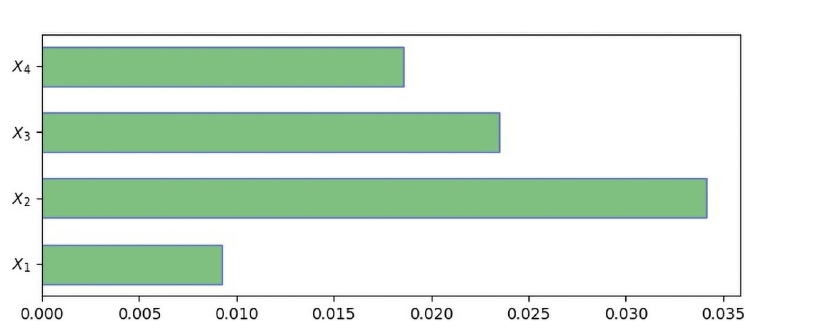
Fig 5. LIME values to estimate variables’ prediction contributions. Note. X 1 = performance; X 2 = expectations; X 3 = disconfirmation; X 4 = enjoyment.